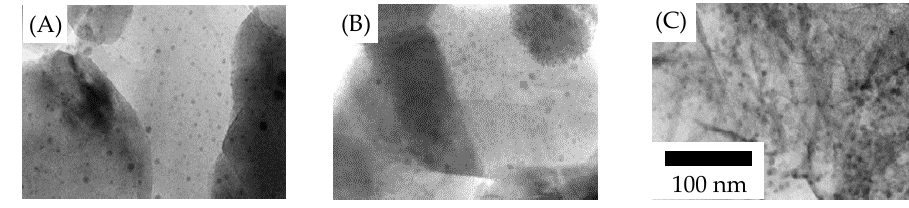
Figure 3. BSE images of Ag over Ag(5.6)-Na(1) / CaCO 3 ( A ) and Ag(56)-Na(1) / CaCO 3 ( B ). The scale of these figures is the same.